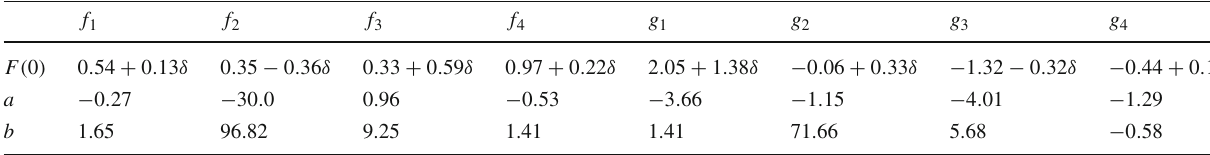
Table 4 (cid:6) 0 c → (cid:6) − transition form factors with F(0) at q 2 =